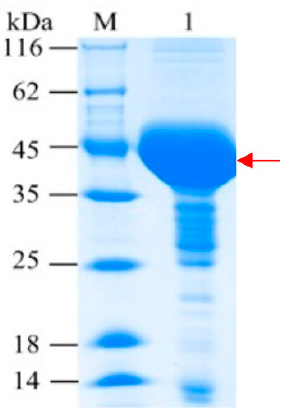
Figure 2. SDS-PAGE analysis of purified Bs-YjiC. M: Protein marker; 1: Purified Bs-YjiC.